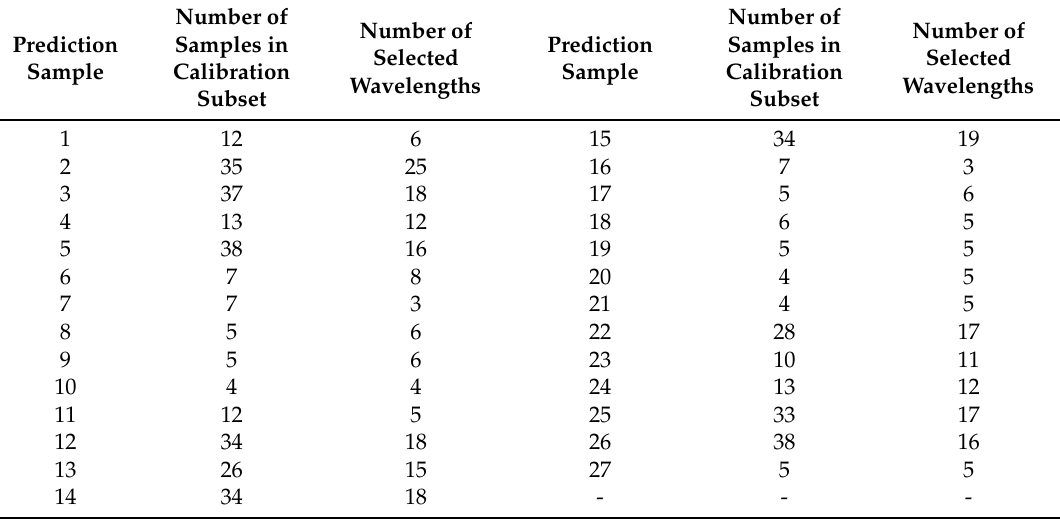
Table 3. The final size of the calibration subset for each unknown sample in the prediction